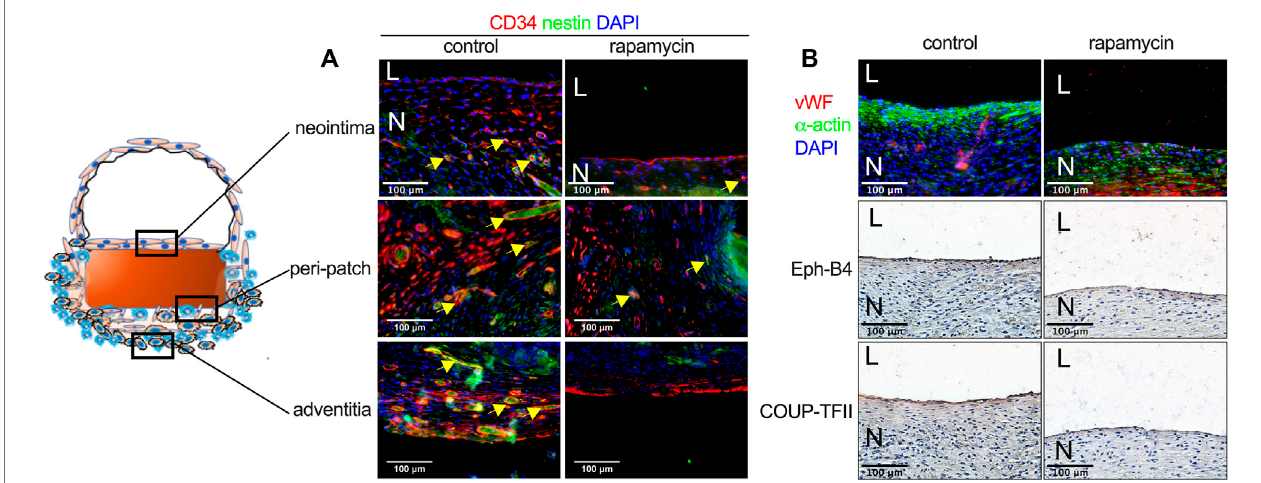
FIGURE 5 | Rapamycin does not in fl uence neointimalendothelial progenitor cell migration or venous identity. (A) Immuno fl uorescence showing CD34 (red), nestin (green), and DAPI (blue) in the neointima, the peri-patch area, and the adventitia yellow arrow showing the positive cells, scale bar, 100 µm; n = 3. (B) First row: immuno fl uorescence showing vWF (red), α -actin (green) and DAPI (blue) in the neointima; second and third rows: immunohistochemistry showing Eph-B4 and COUP- TFII, respectively; scale bar, 100 µm n = 3.